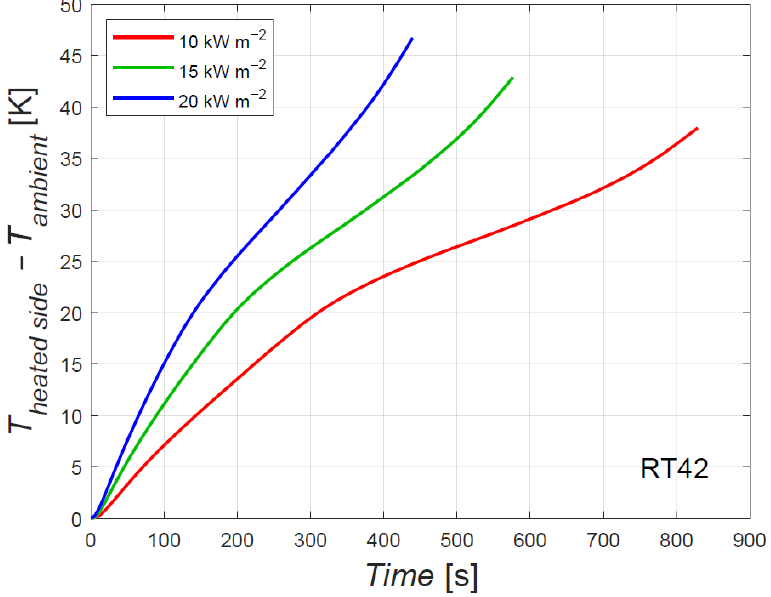
Figure 7. Temperature difference profiles for the paraffin RT42 at different heat fluxes.